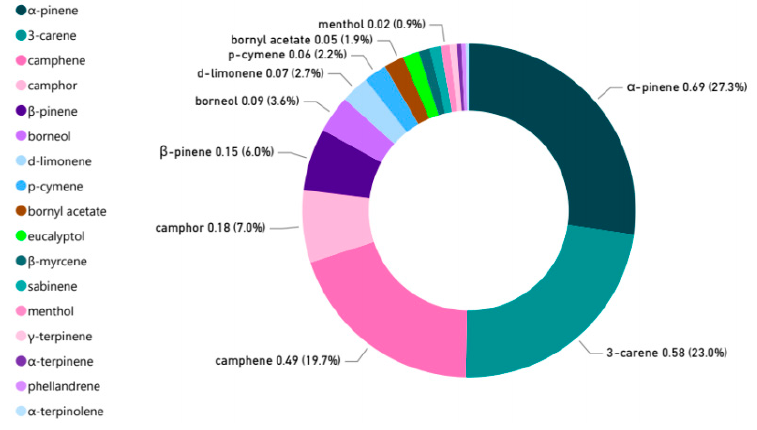
Figure 3. Emission analysis of bamboo groves by NVOC components.